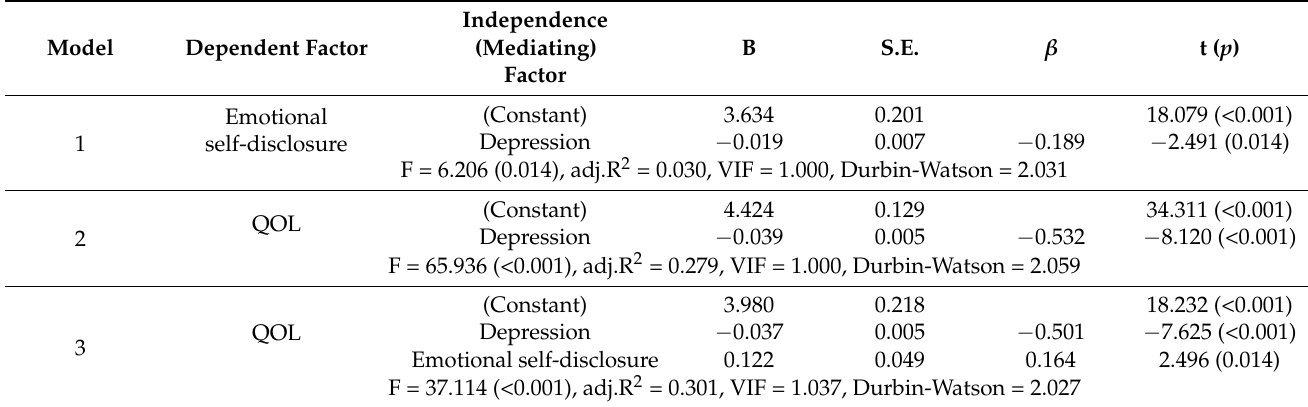
Table 5. Mediating effect of emotional self-disclosure in the relationship between depression and QOL ( n = 169).